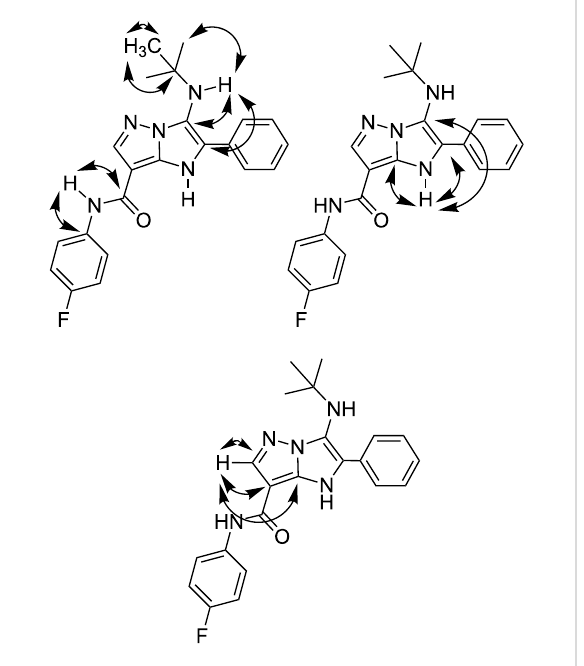
Ultimately, the structure of compounds 9 was proven by an X-ray analysis of compound 9e (Figure